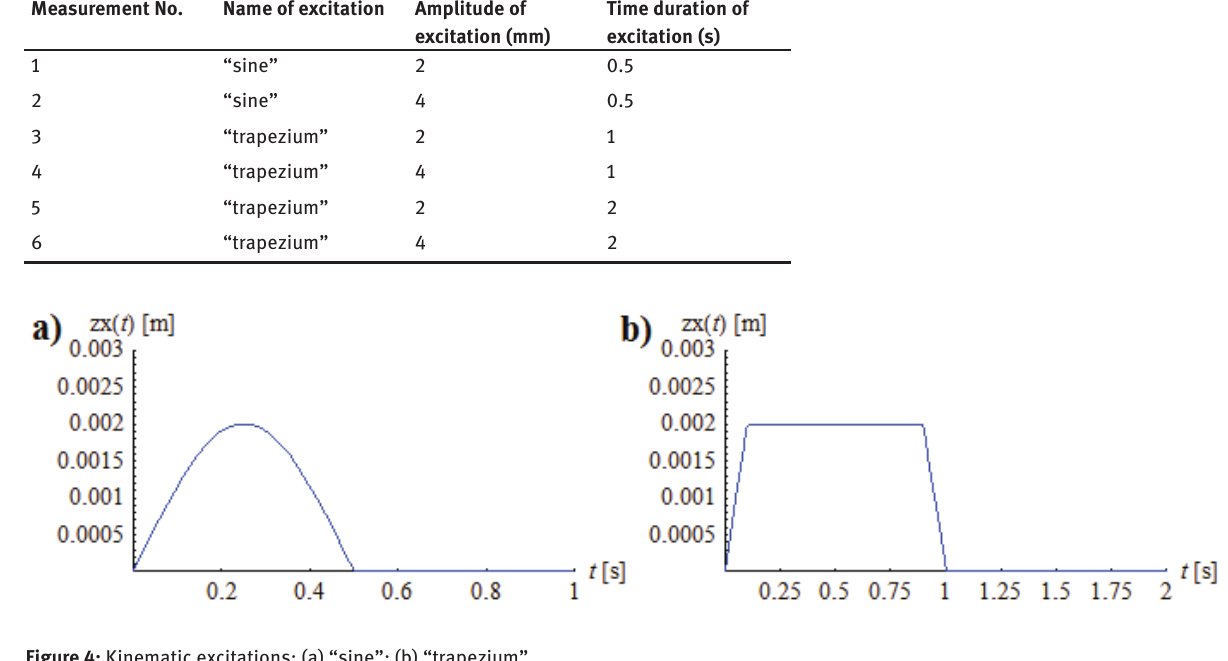
Figure 4: Kinematic excitations: (a) “sine”; (b)